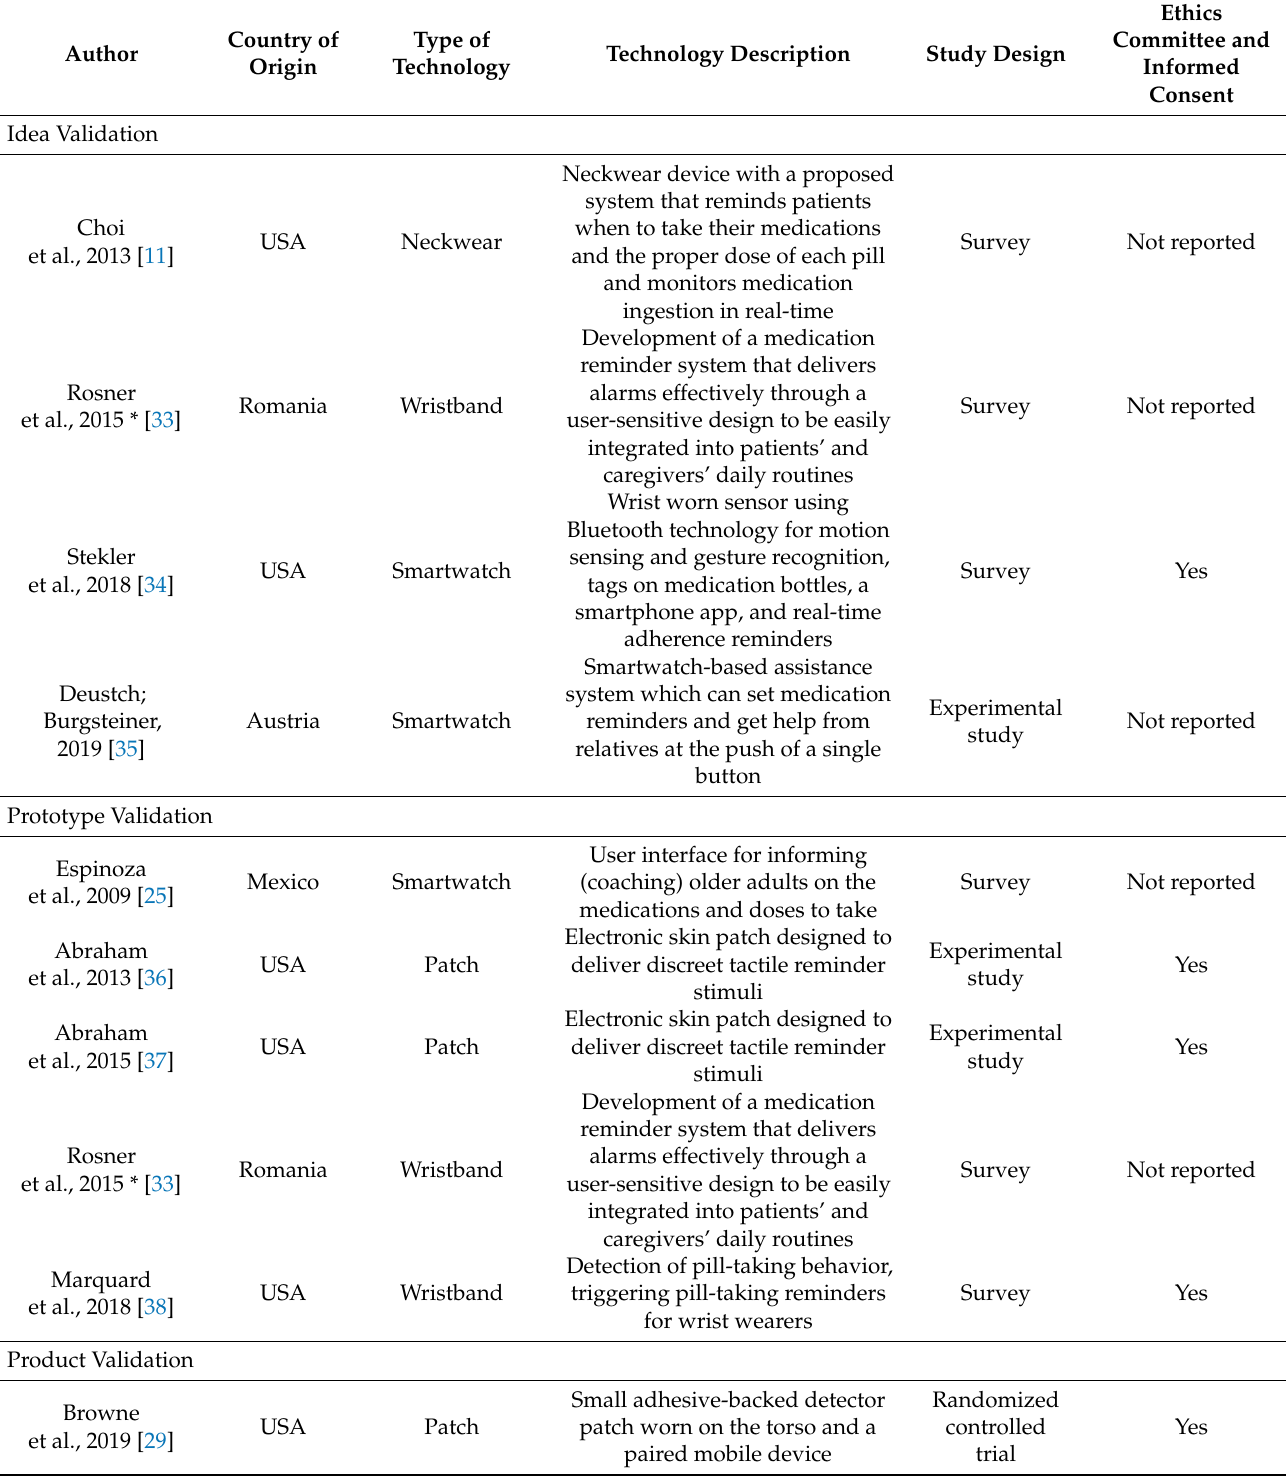
Table 2. Characteristics of studies included in